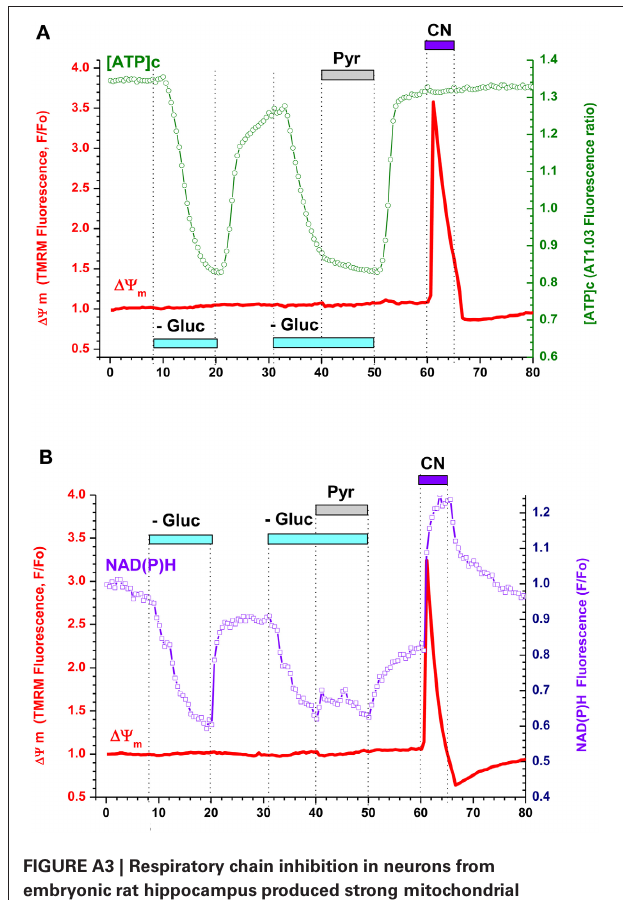
FIGURE A3 | Respiratory chain inhibition in neurons from embryonic rat hippocampus produced strong mitochondrial depolarization despite sufficiently high [ATP]c and NAD(P)H levels suggesting an increase in mitochondrial proton conductance. (A) Simultaneous measurement of [ATP]c (green trace, right axis) and (cid:2)(cid:3) m (red trace, left axis) in neurons expressing AT1.03 and loaded with TMRM. Gluc-free buffer application is indicated with a light-blue bar, pyruvate (Pyr, 10mM) with a gray bar, and cyanide (CN, 3mM) with a dark blue bar. (B) Simultaneous measurement of averaged NAD(P)H autofluorescence (blue trace, right axis) and (cid:2)(cid:3) m (red trace, left axis) in two non-transfected neurons located in the same field of view as those shown in (A) . Pharmacological manipulations—same as in (A)